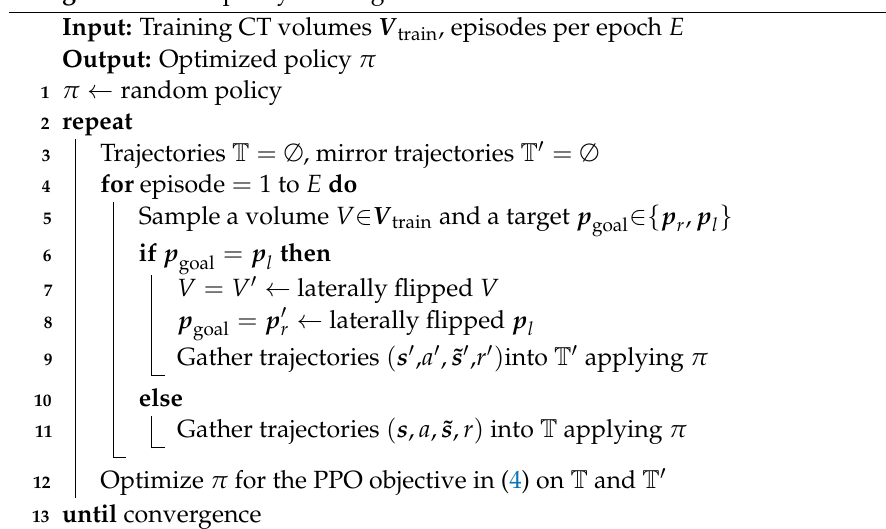
Algorithm 1: RL policy training with mirror